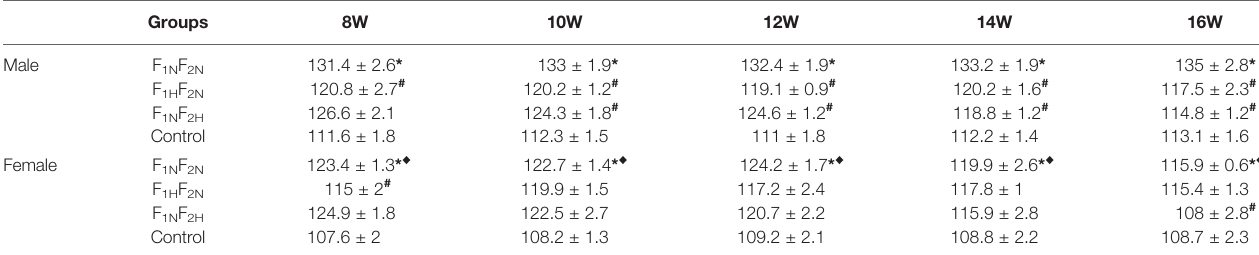
TABLE 1 | Time courses of changes in systolic blood pressure (SBP) in four different groups of male and female offspring. Groups